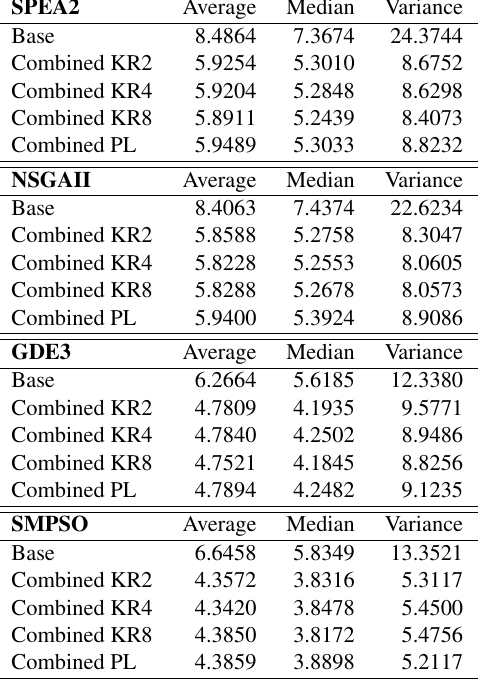
Table 5. UR - Unrealized Returns